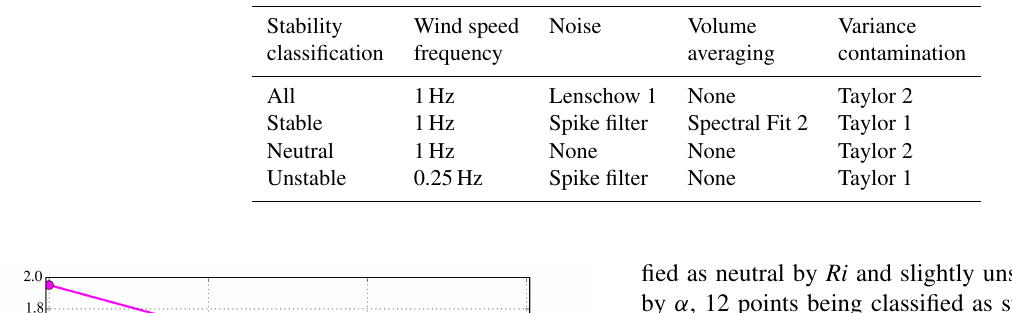
Table 5. L-TERRA model combinations that minimized TI MAE for different stability conditions at the ARM site and Southern Plains wind farm.